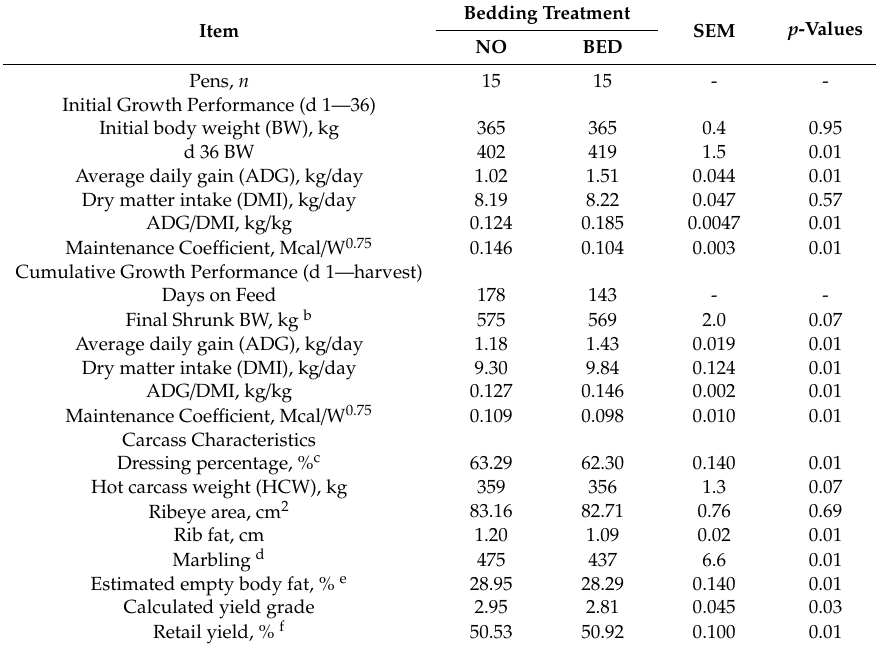
Table 3. Experiment 1: Effect of bedding on cattle growth performance and carcass characteristics a .